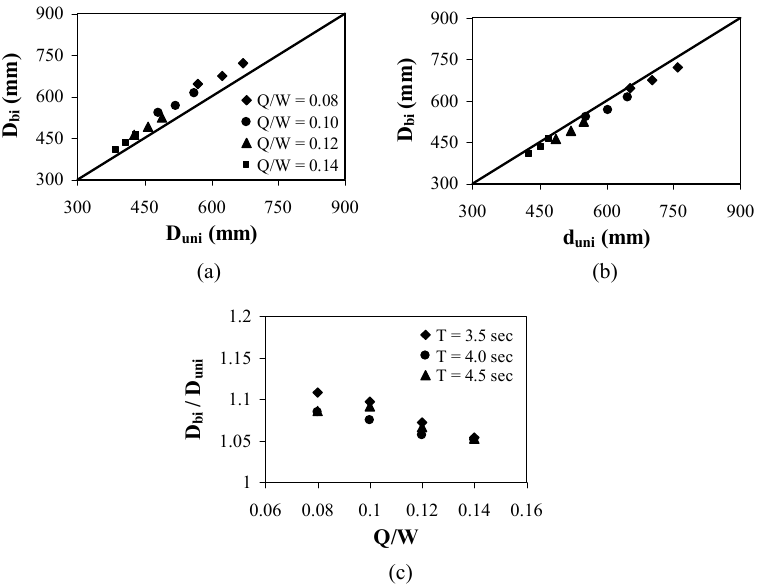
Fig. 6. Comparison of D bi and D uni obtained from NRHA with d bi and d uni calculated as per ASCE (2005) regarding ground motions in Bin2. directional excitations are compared with each other and with calculations of ELF procedure ( d uni and d bi ). All of the plots in this section show only the average of the results for all